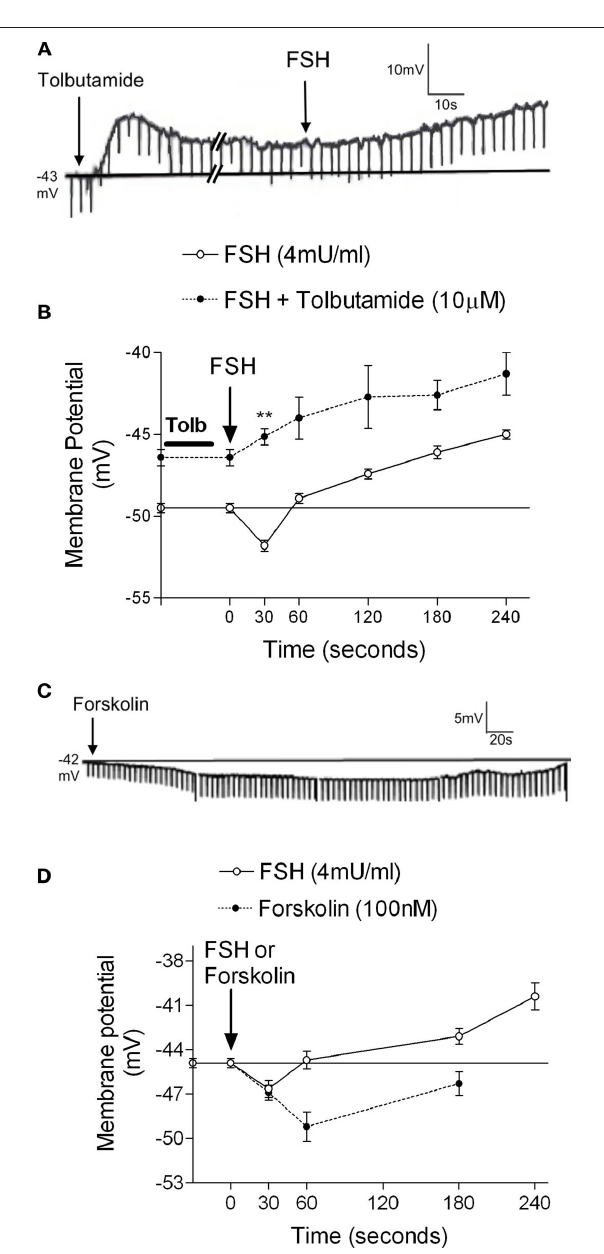
Figure 1 | effect of 1 h of PTX pre-incubation (1 μg/ml) on the action of FSH (4 mu/ml) on the membrane potential of 10- to 12-day-old rat Sertoli cells. Register of a Sertoli cell with resting potential of E (A) . Typical response of cells treated with FSH without (B) and with PTX (C) . (D) Changes of membrane potential produced by FSH application with or without PTX. Statistical analysis: two-way ANOVA followed by Bonferroni post test, ** p < 0.001; n = 5 in each treatment (FSH or FSH plus PTX) from five separated experiments.